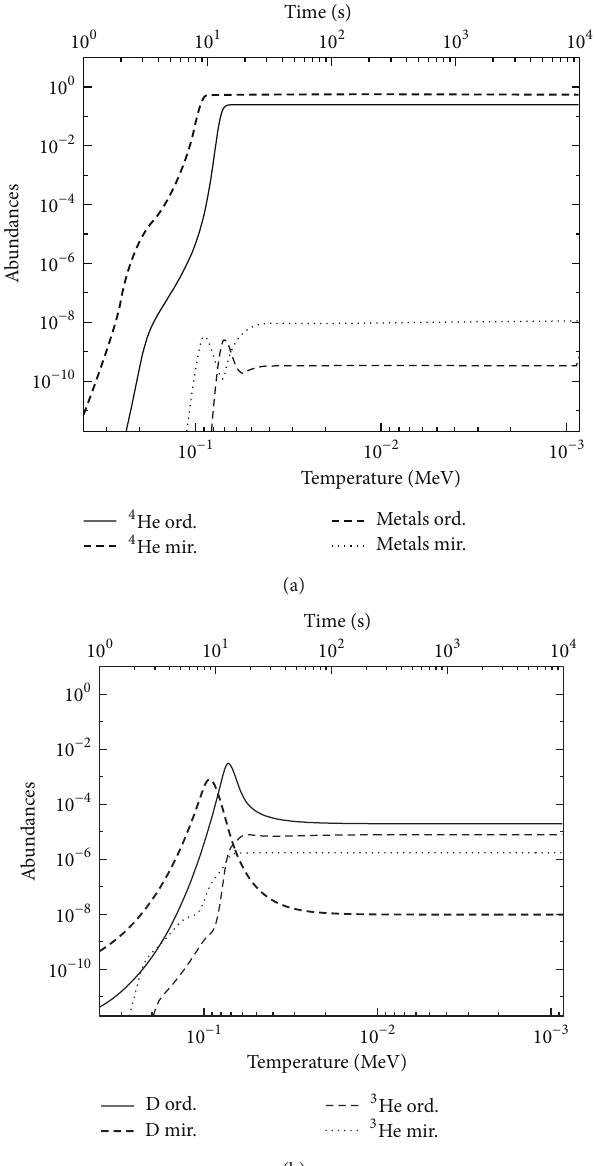
Figure 3: Time/temperature evolution of nuclides during ordinary and mirror primordial nucleosynthesis. The models have the mirror parameters 𝑥 = 0.4 and 𝛽 = 5